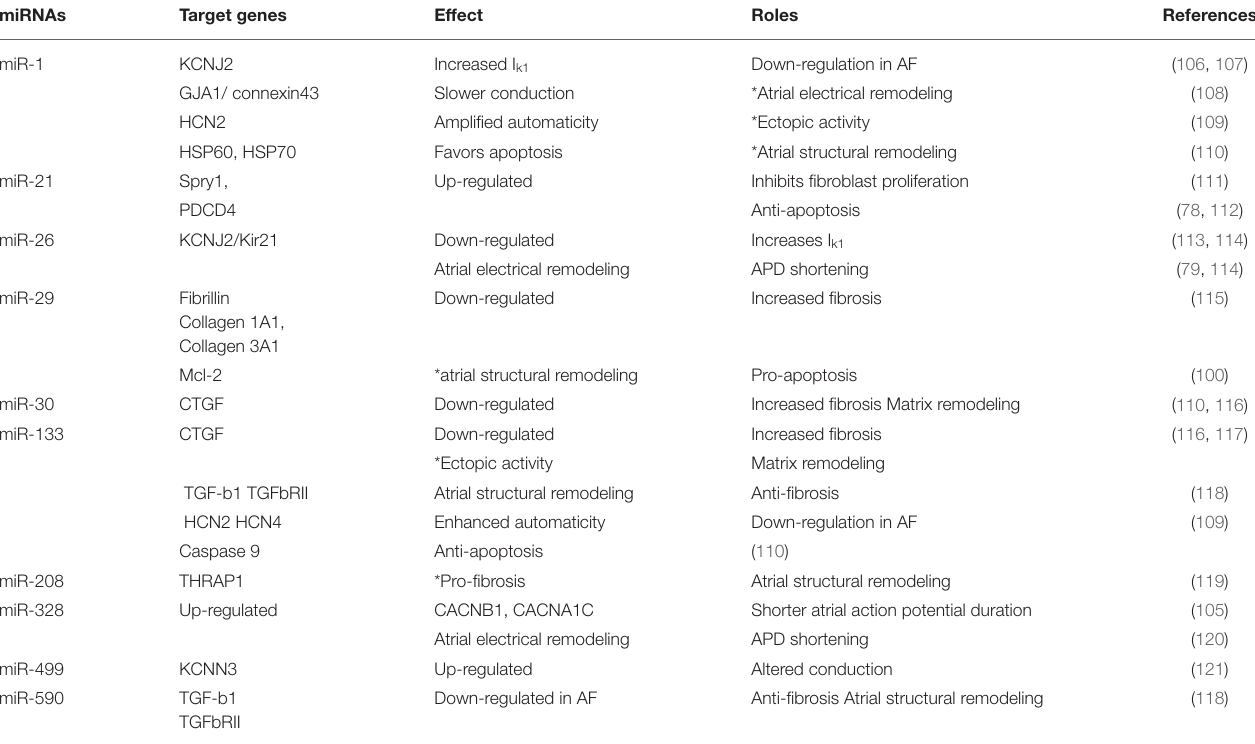
TABLE 1 | miRNAs involved in the electrical and structural changes in atrial